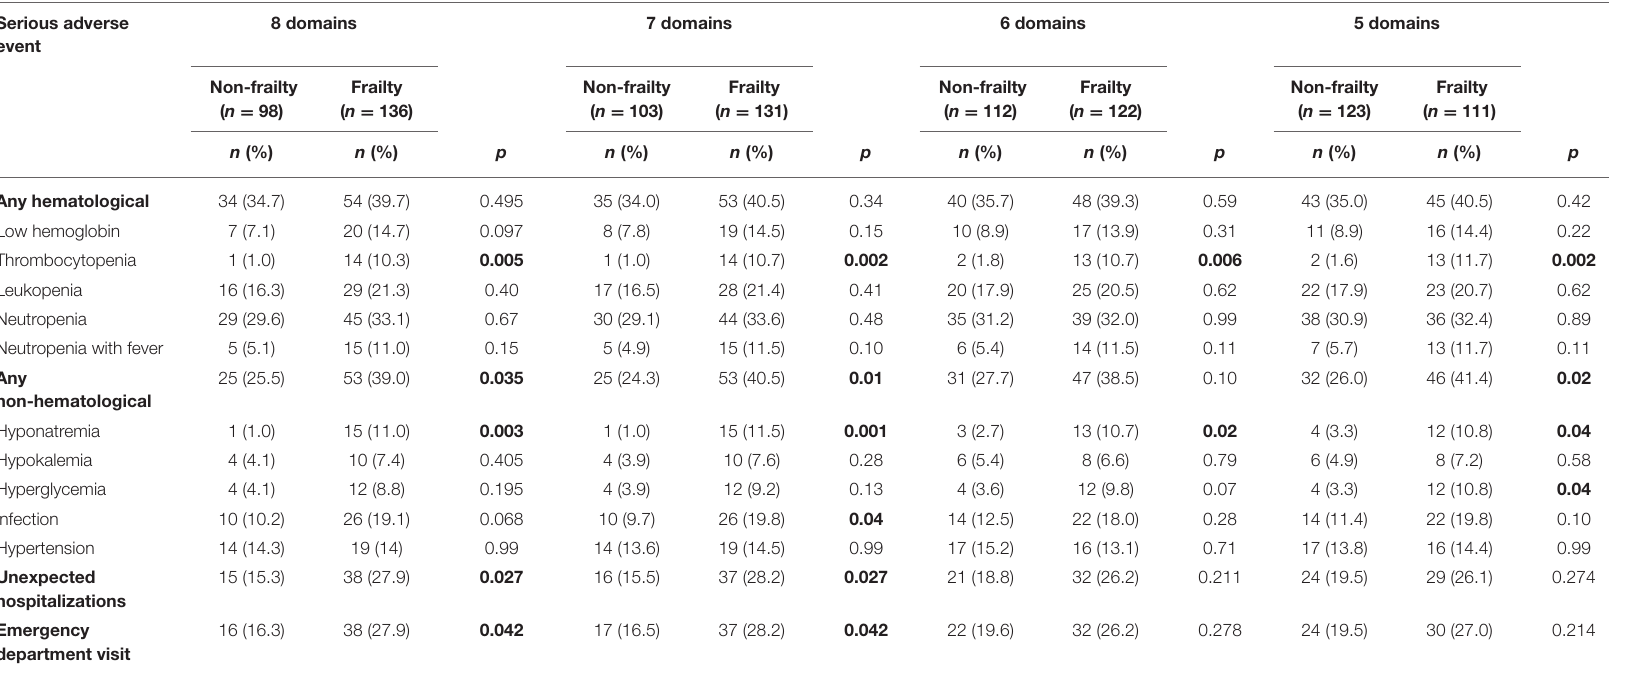
TABLE 4 | Association of the frailty assessed in a different number of dimensions to serious chemotherapy adverse events in older cancer patients ( N =